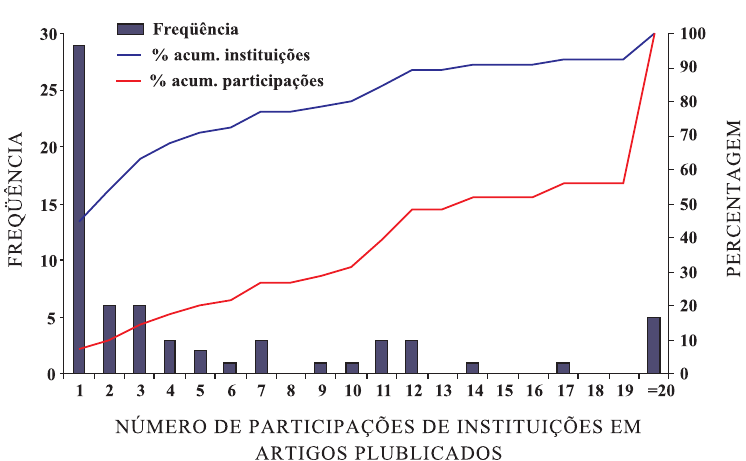
Figura 2. Histograma de participação de instituições em artigos sobre erosão do solo.